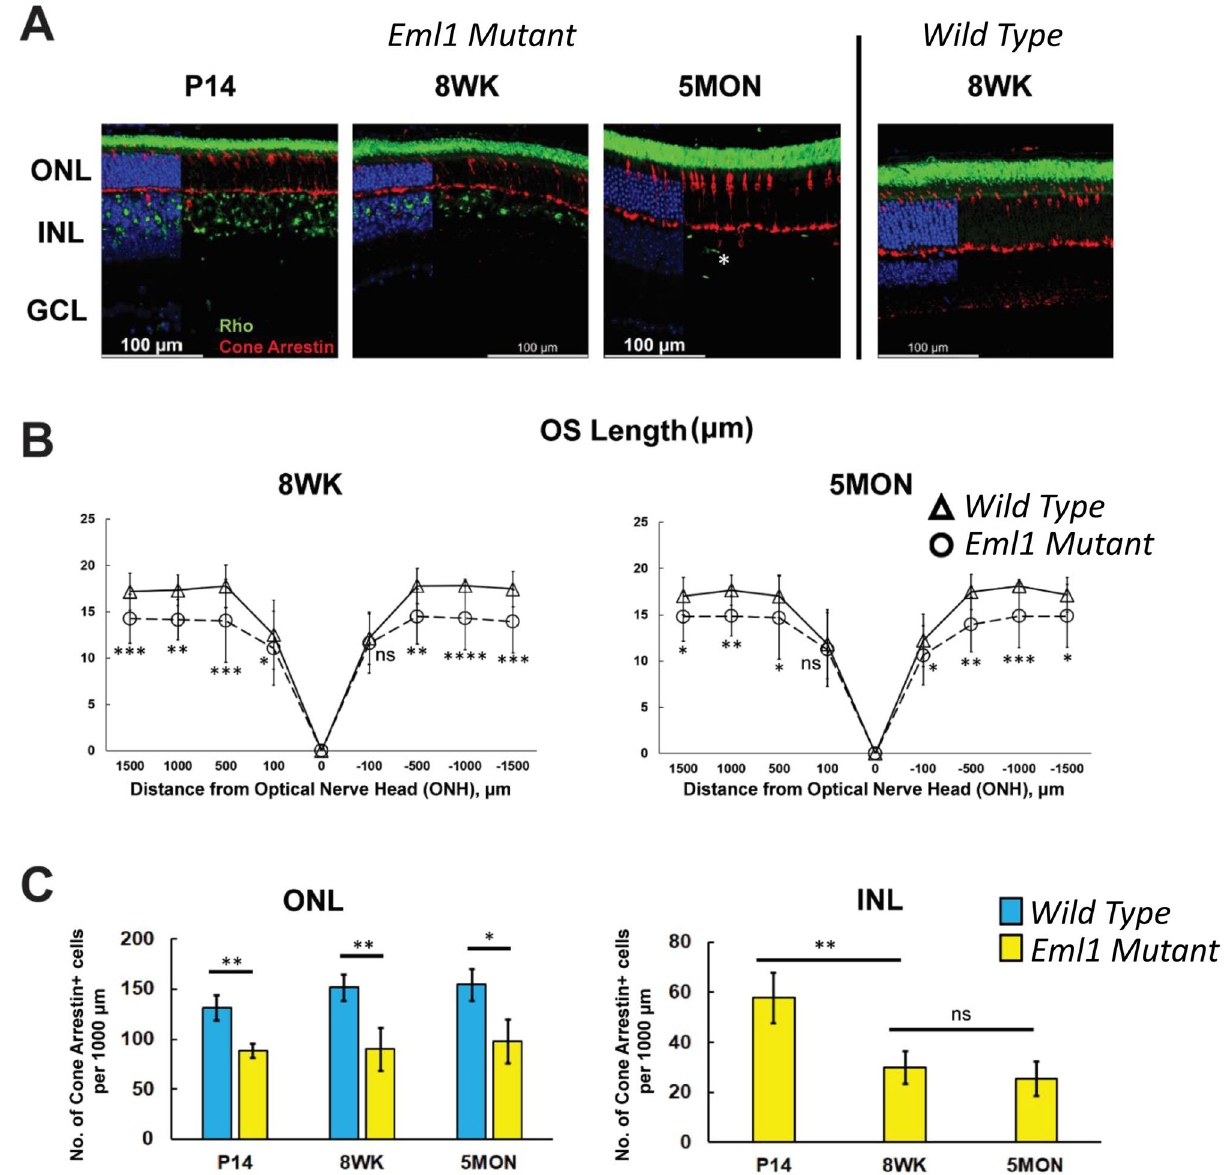
Figure 8. Identification of the mislocalized cells in Eml1 mutant retina. ( A ) Immunofluorescence staining from the Eml1 mutant retina at P14, 8 weeks and 5 months ( left panels ) and wild type retina at 8 weeks ( right panel ) for rhodopsin ( green ) and cone arrestin ( red ) and nuclear stain DAPI ( blue ). An outer segment of a rhodopsin- positive cell within the INL in the Eml1 mutant retina at 5 months ( starred ). Images of the 220 µm acquisition were taken at 1000 µm from ONH. ( B ) The outer segment length as a function of the distance from the optic nerve head presented as spider plots in the Eml1 mutant retinas ( circles ) and wild type retinas ( triangles ) at 8 weeks ( left ) and 5 months ( right ). ( C ) Cone cell density analysis in ONL ( left ) and INL ( right ) in wild type retinas ( blue ) and Eml1 mutant retinas in a 1000 µm-wide retina section ( yellow ). Error bars show S.D. for all